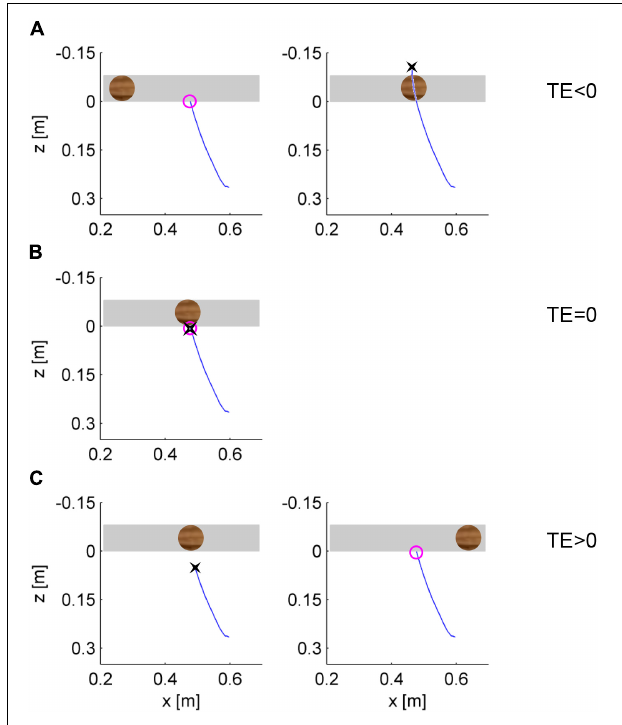
FIGURE 4 | Top view of the relative position of the ball and hand in three hypothetical cases. Each panel is a snapshot representing the relative position of the ball and hitter in the horizontal plane at a given time. The gray region delimits the proximal and distal frontal planes tangent to ball surface. The blue lines depict the paths that led the hitter at the position depicted in the panel. The black cross denotes the position IP in which the hitter first arrived at the minimum distance from the ball surface during ball motion. The purple circle denotes the position of the hitter when it first crossed the proximal frontal plane tangent to the ball surface. (A) The hitter arrives early relative to the ball, and the timing error (TE) is negative. (B) The hitter arrives on time (TE = 0). (C) The hitter arrives late (TE >